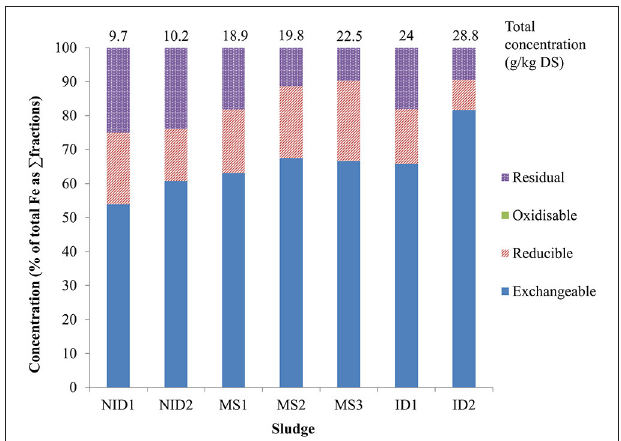
FIGURE 2 | Iron fractionation profiles in the 7 anaerobically digested sludge (NID, non-iron dosed sludge; MS, mixed sludge; ID, iron dosed